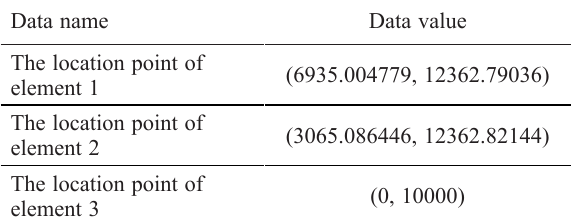
Table 3. Data extracted from model B